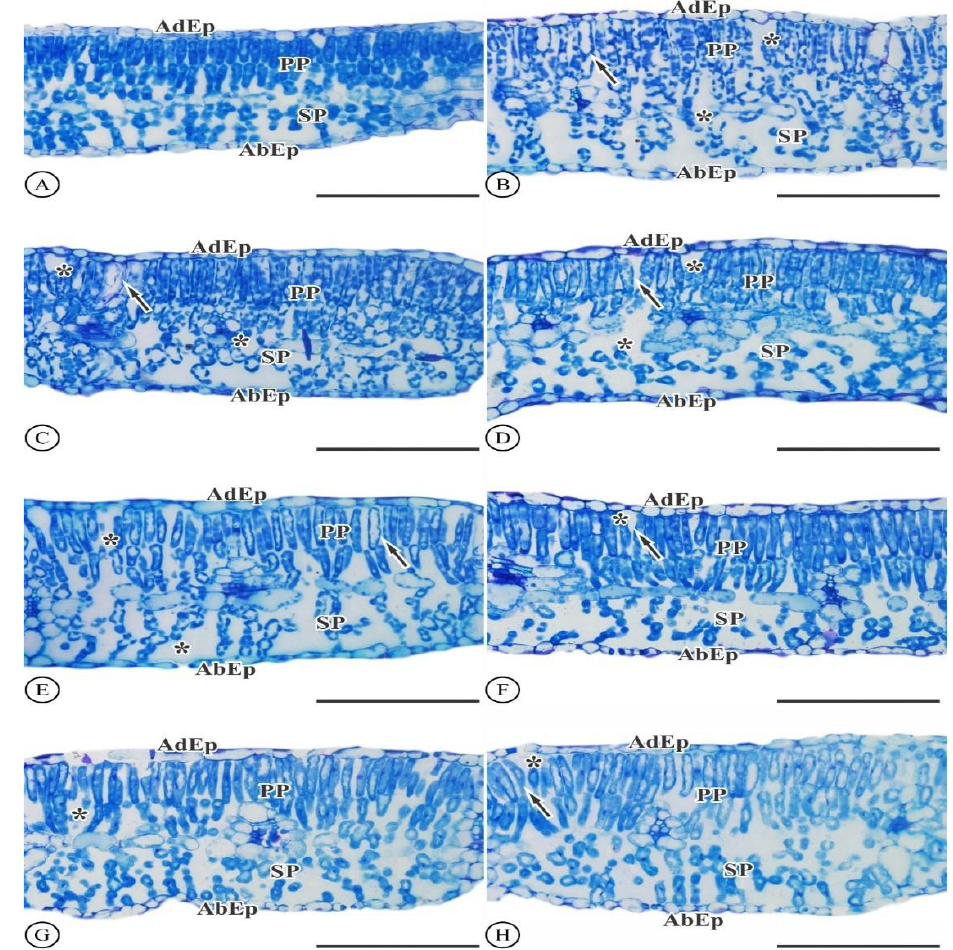
Figure 2. Leaf anatomy of soybean plants treated with doses of potassium phosphite and exposed to water deficit + high irradiance for 12 days: ( A ): Control 90% FC, ( B ): 40% FC + HI, ( C ): 40% FC + 1.2 L/ha −1 PP + HI, ( D ): 40% FC + 0.6 L/ha −1 P € HI, ( E ): 50% FC + HI, ( F ): 50% FC + 1.2 L/ha −1 PP + HI, ( G and H ): 50% FC + 0.6 L/ha −1 PP + HI. AdEp, adaxial epidermis; AbEp, abaxial epidermis; PP, palisade parenchyma; SP, spongy parenchyma. Asterisk indicates increased intracellular spaces. Black arrows indicate cell collapse; 200 µm scale bar.